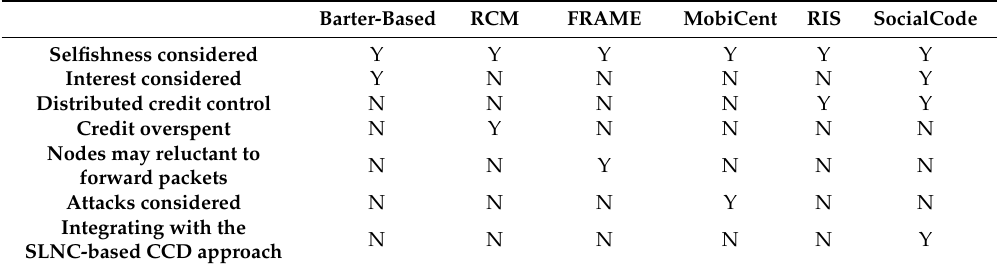
Table 1. Characteristics of related credit-based incentive